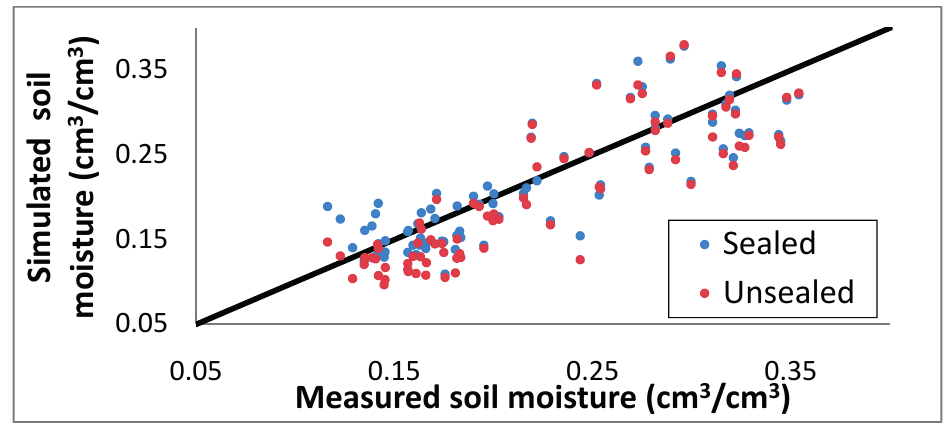
Figure 2. Model simulations vs. measured soil-moisture data averaged for the 0–10-cm soil depth. The 1:1 line is drawn in